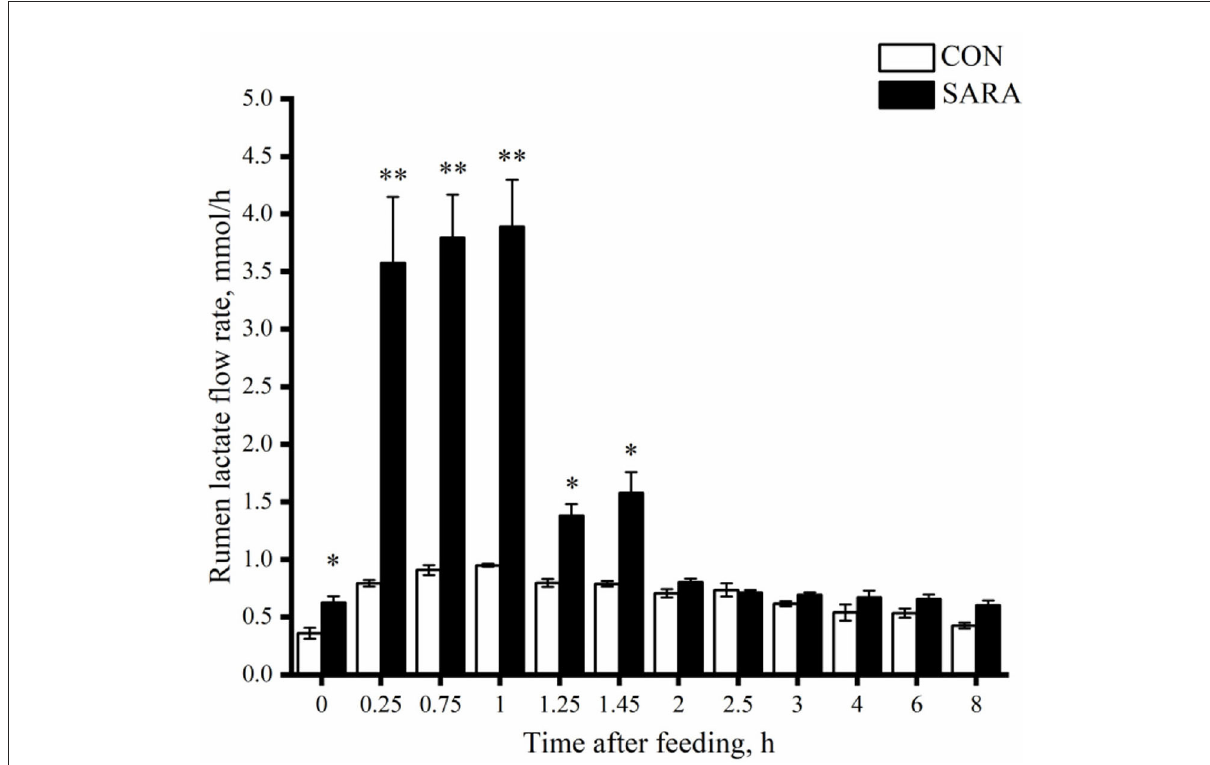
FIGURE4 The dynamic variation of lactate concentration in the rumen fluid of goats under normal (CON) or SARA condition. Data were expressed as mean ± SEM ( n = 6). Significant differences are denoted by * P < 0.05, and extremely significant differences are indicated by ** P <